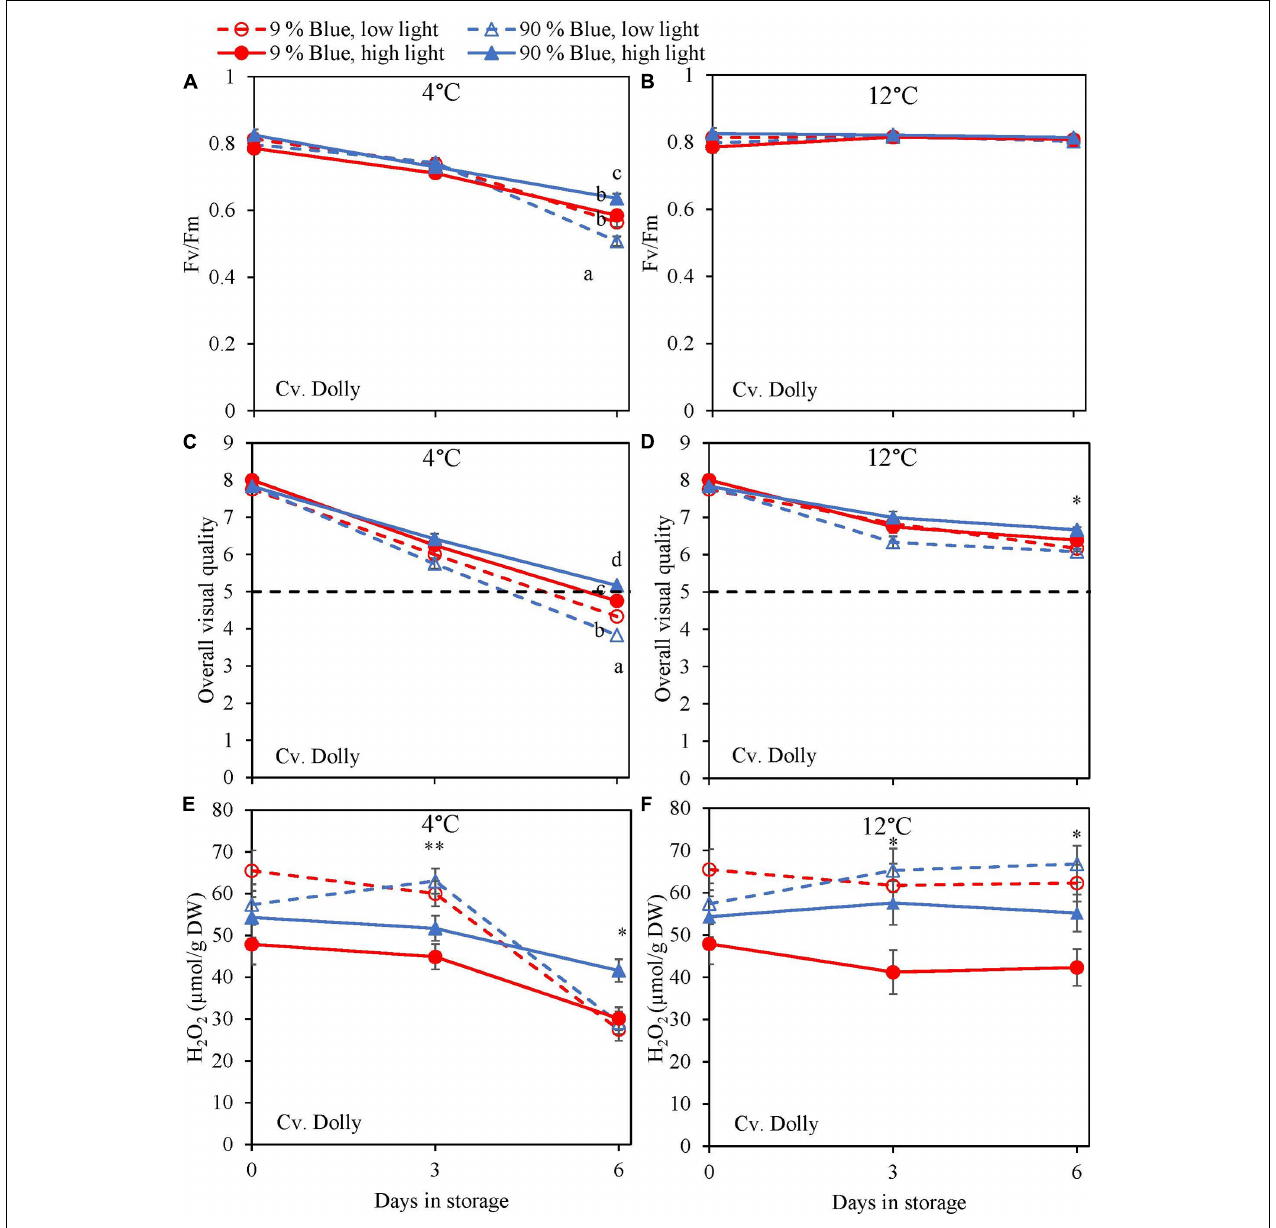
FIGURE 6 | Changes in chilling injury parameters during postharvest storage at 4 (A,C,E) and 12 ◦ C (B,D,F) in basil in the green cv. Dolly were exposed to EOP treatments. Plants were grown under red-white light (PPFD of 200 µ mol m − 2 s − 1 , 9% blue) for 30 days. The last 5 days before harvest plants were exposed to different EOP blue light ratios 9 or 90% at low light (100 µ mol m − 2 s − 1 ) (open symbols) or high light (300 µ mol m − 2 s − 1 ) (closed symbols). (A,B) Change in maximum quantum yield of PSII of dark-adapted leaves (F v /F m ), (C,D) change Overall Visual Quality (OVQ), (E,F) change in hydrogen peroxide (H 2 O 2 ) content. All metabolite values are expressed per gram dry weight in leaves. The data are means of three blocks ( n = 3) (i.e., per block four replicate plants). Standard errors of means are shown as error bars. If no interaction was found but only the main effects were significant the indicated with p -values; * p < 0.05, ** p < 0.01, are depicted with either a blue (percentage of blue light) or black asterisk (PPFD). Letters indicate and interactive effect between the two main effects (percentage of blue light and PPFD), (Experiment